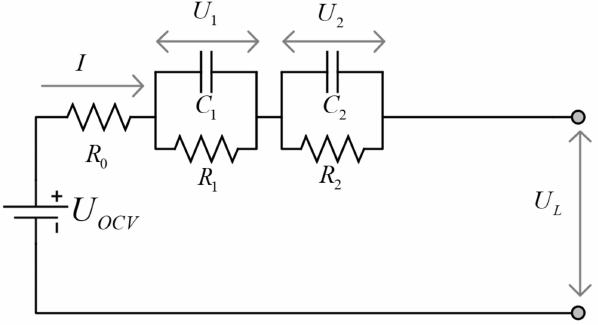
Figure 3. Model structure of second-order resistor-capacitor (2RC).